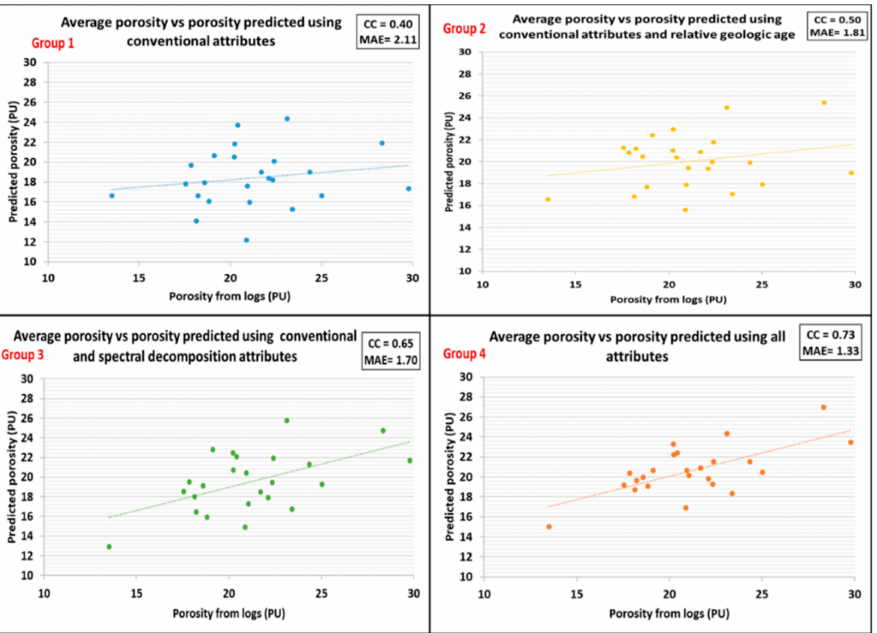
Figure 14. Cross-plots of the actual versus predicted average porosity extracted over a 20-ms window below the main reservoir. Abbreviations: CC, correlation coefficient and MAE, mean absolute error.